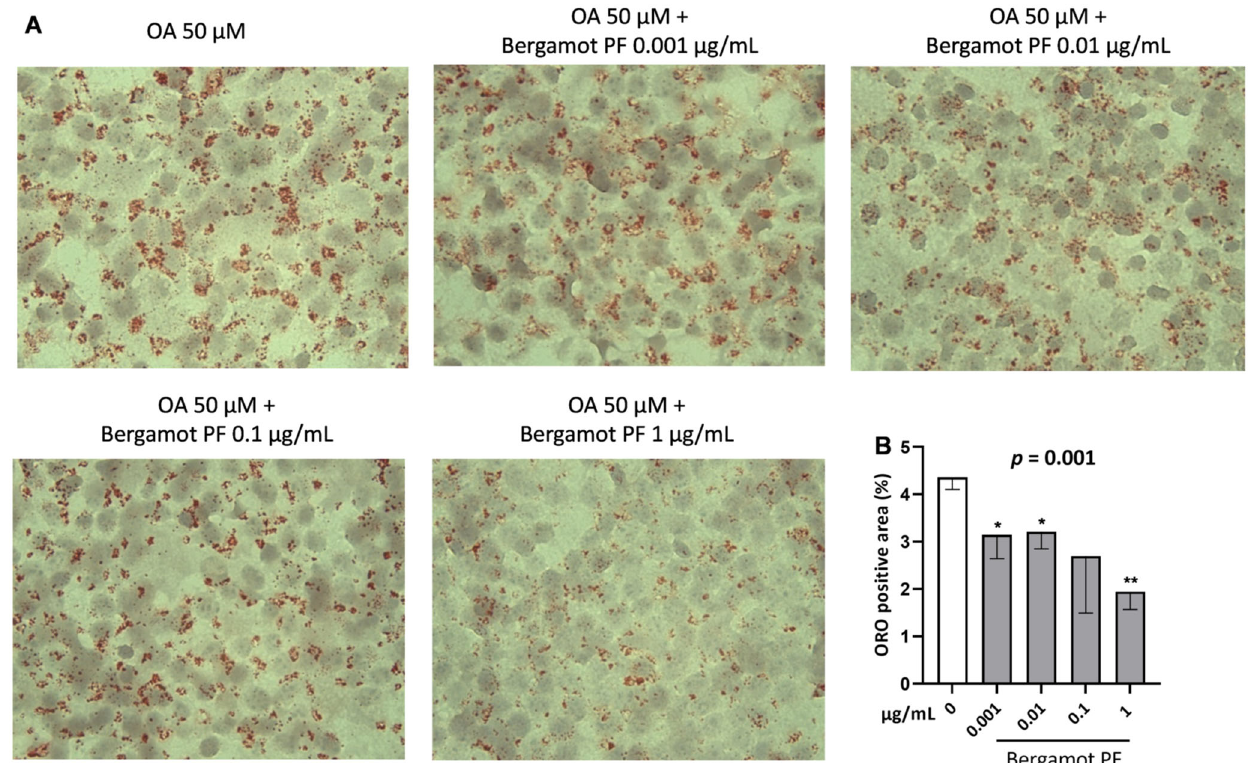
Figure 1. Incubation with bergamot PF extract reduces intracellular lipid content in 2D cultured hepatocytes. Rat hepatoma cell line McA-Rh-7777 was cultured in 2D and incubated with 50 µ M of oleic acid and different concentrations of bergamot PF extract (0.001, 0.01, 0.11 μ g/mL) in regular medium without FBS for 24 h. Intracellular lipid content was measured by Oil red ‐ O staining ( A ). ORO area quantified by Image J ( B ) and showed a significant decrease in intrahepatic lipid content. Data are shown as mean ± SD of three independent experiments. Statistical analysis methods are as follows: Student`s t ‐ test vs. 0 * p < 0.05; ** p < 0.001. Linear regression p = 0.001. Abbreviations are as follows: PF, polyphenols fraction; FBS, fetal bovine serum; OA, oleic acid; 2D, two dimensional; SD, standard deviation; ORO, Oil red ‐ O.